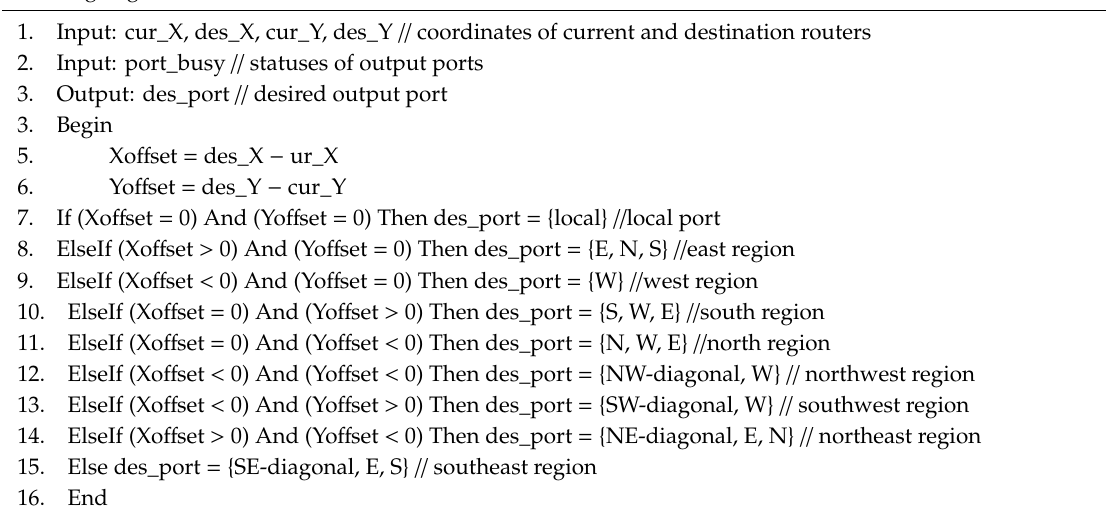
Algorithm 1 Pseudo-code of the modified West-first routing algorithm. Modified West-First Routing